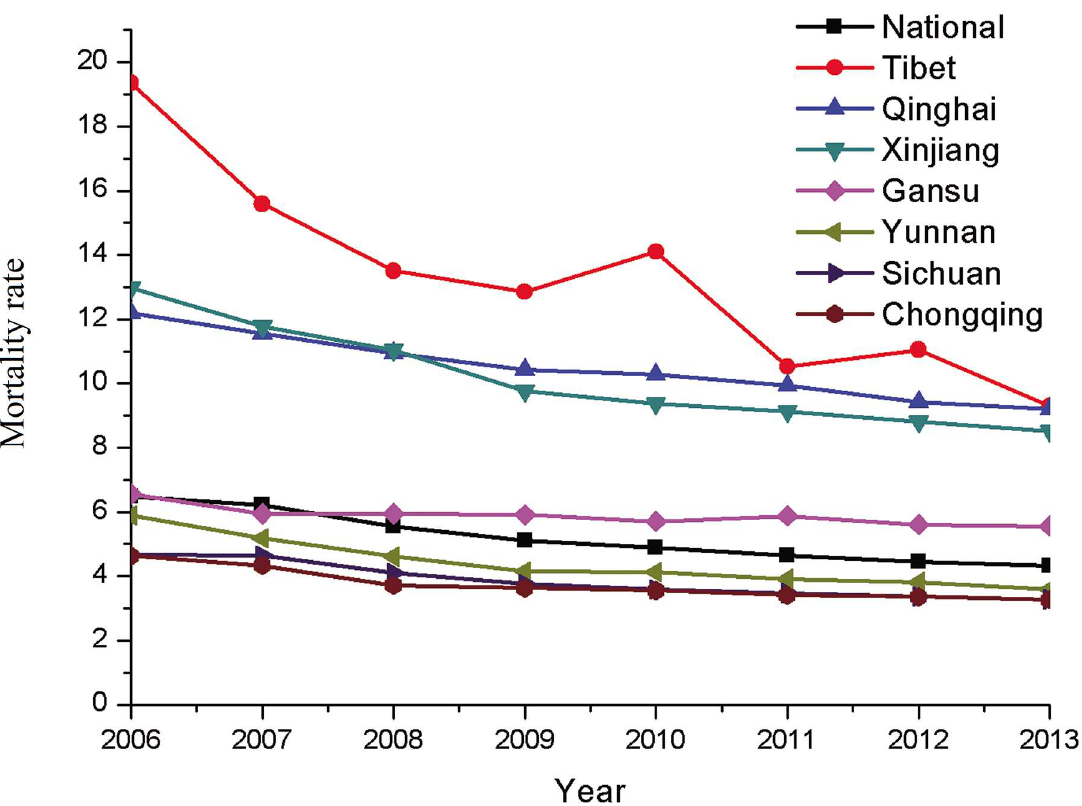
Fig 4. Mortality rate per 100 000 populations from 2006 to